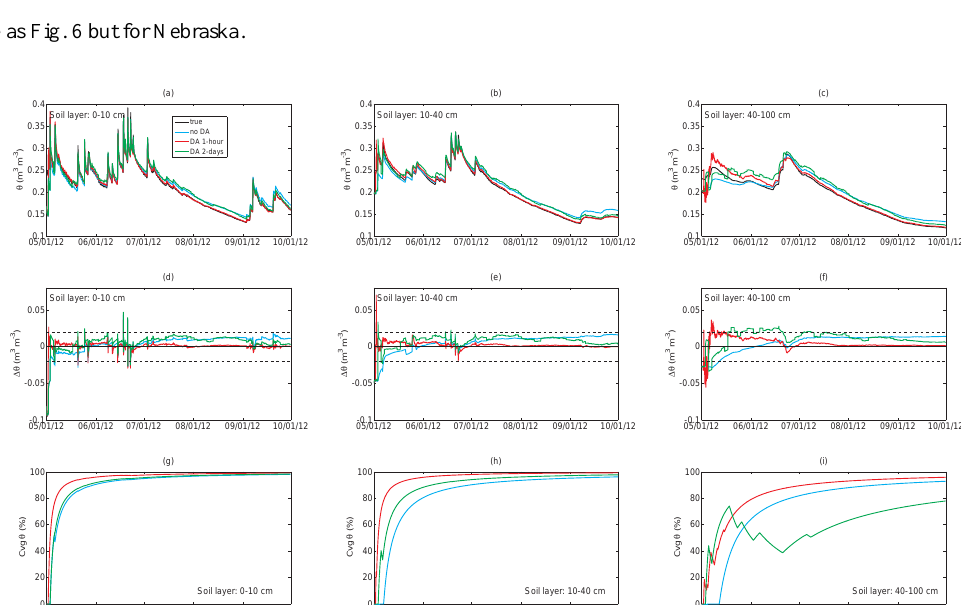
Figure 7. Same as Fig. 6 but for Nebraska.